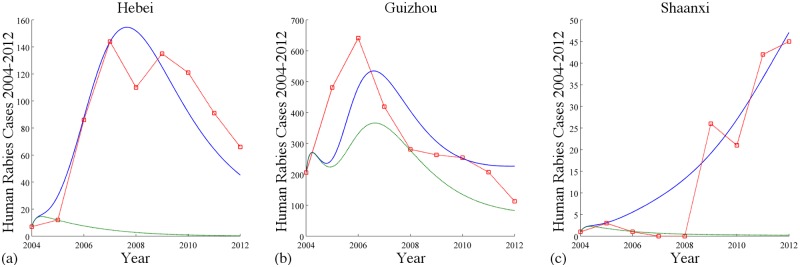
Simulations of the numbers of reported human rabies cases in Guizhou, Hebei, and Shaanxi with dog immigration and without dog immigration.The dashed red curves are reported cases by China CDC; the solid blue curves correspond to simulations with immigration and the dashed green curves correspond to simulations without immigration (ϕ12K=ϕ21K=0 for K = S, E, I, V).